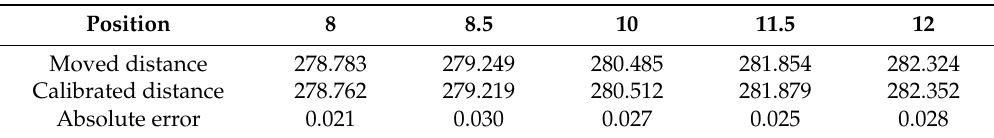
Table 1. Direct test of the calibrated distance using the moving stage at the positions of 8 mm, 8.5